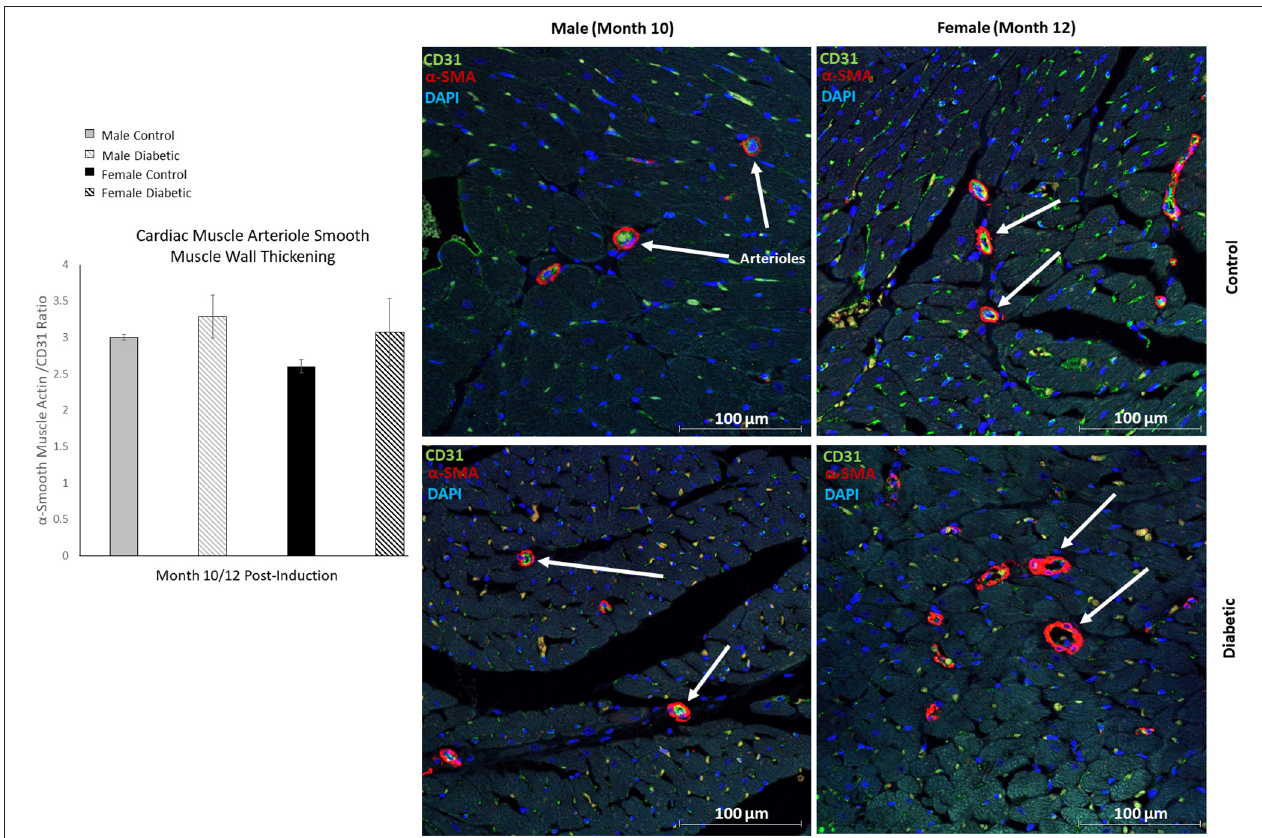
FIGURE 6 | Immunofluorescence of small arteriole perivascular smooth muscle wall in the myocardium shows no thickening in either sex. Quantification expressed as a ratio of surface area coverage of α SMA to CD31 for each arteriole (10–25 µ m). Assessment conducted at 10 and 12 months post-induction for males and females, respectively ( n = 3 control male, n = 4 diabetic male, n = 3 control female and n = 4 diabetic female). White arrows highlight representative arterioles from each cohort. Data represented as mean ± SEM.